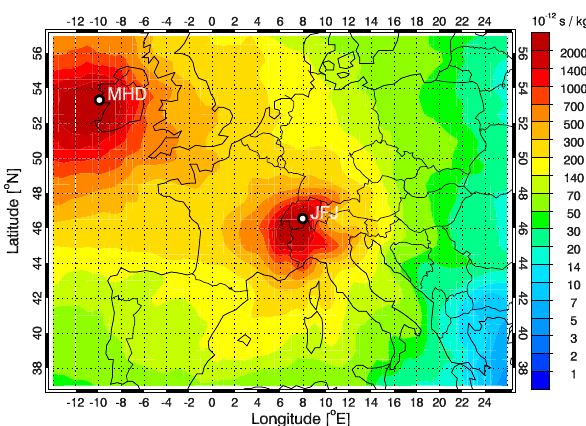
Fig.2. Footprintemissionsensitivity(inpicosecondsperkilogram) Fig. 2. Footprint emission sensitivity (in picoseconds per kilogram) averagedoverallairmassesarrivingatJungfraujoch(JFJ)andMace averaged over all air masses arriving at Jungfraujoch (JFJ) and Mace Head (MHD) between February 2006 and December 2010. Head (MHD) between February 2006 and December